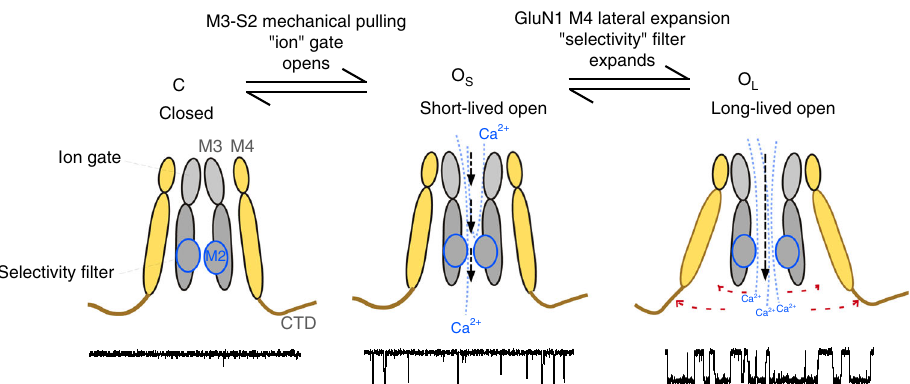
Fig. 9 Expansion of the inner pore permitted mainly by the GluN1 M4 conserved glycine facilitates NMDAR gating and Ca 2 + permeation. Cartoon of NMDAR pore structure, including the in fl uence of the GluN1 M4 on open state stability and selectivity fi lter integrity. Subunits are colored light orange (GluN1) and